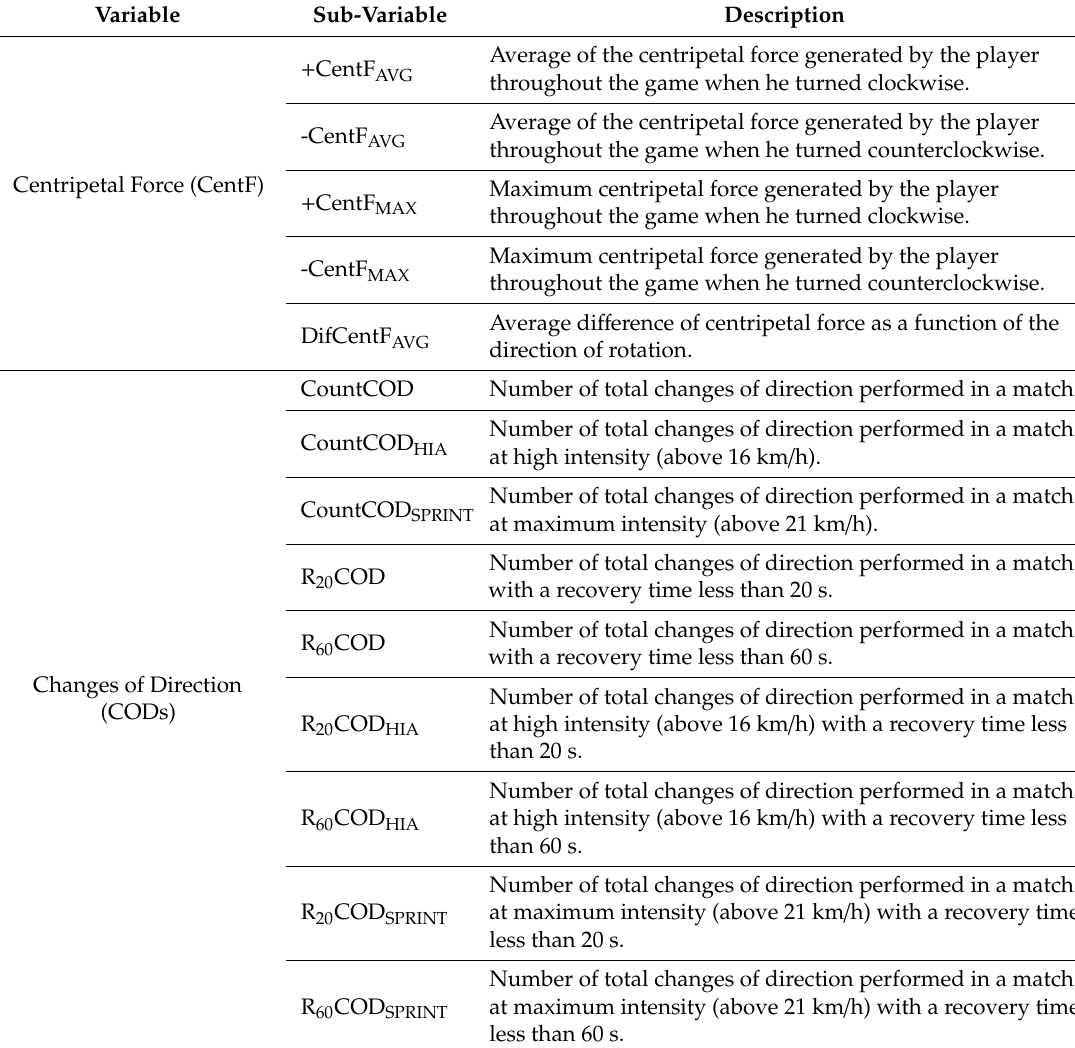
Table 1. Description of centripetal force and change of direction analyzed variables during the present